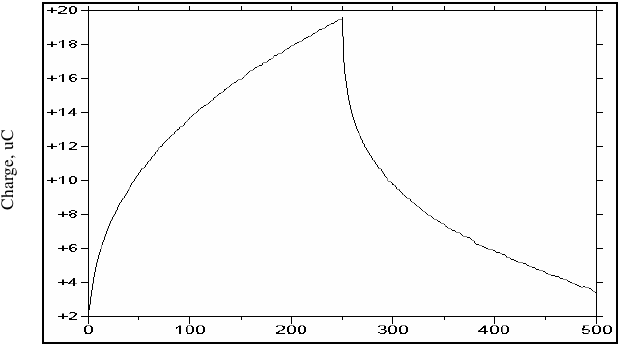
Figure 7. Chronoamperogram of paracetamol at the MgB